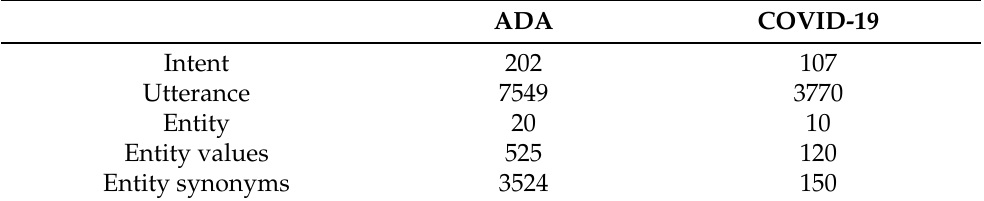
Table 3. The number of intents, utterances, entities to make ADA and COVID-19 functional in